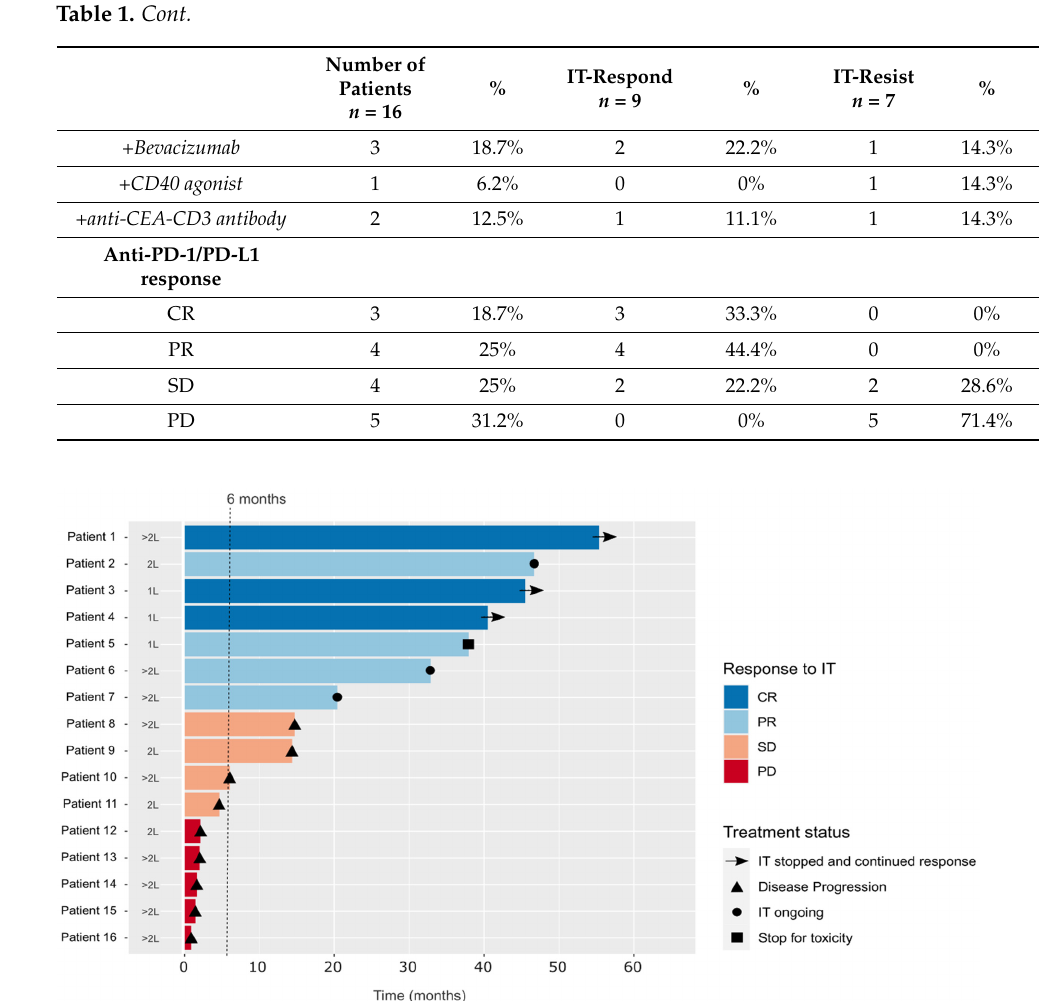
Figure 1. Line of anti-PD-1/PD-L1 administration (1L: first line, 2L: second line, >2L: 3rd line and beyond), PFS to anti-PD-1/PD-L1 for individual patients, best response to anti-PD-1/PD-L1